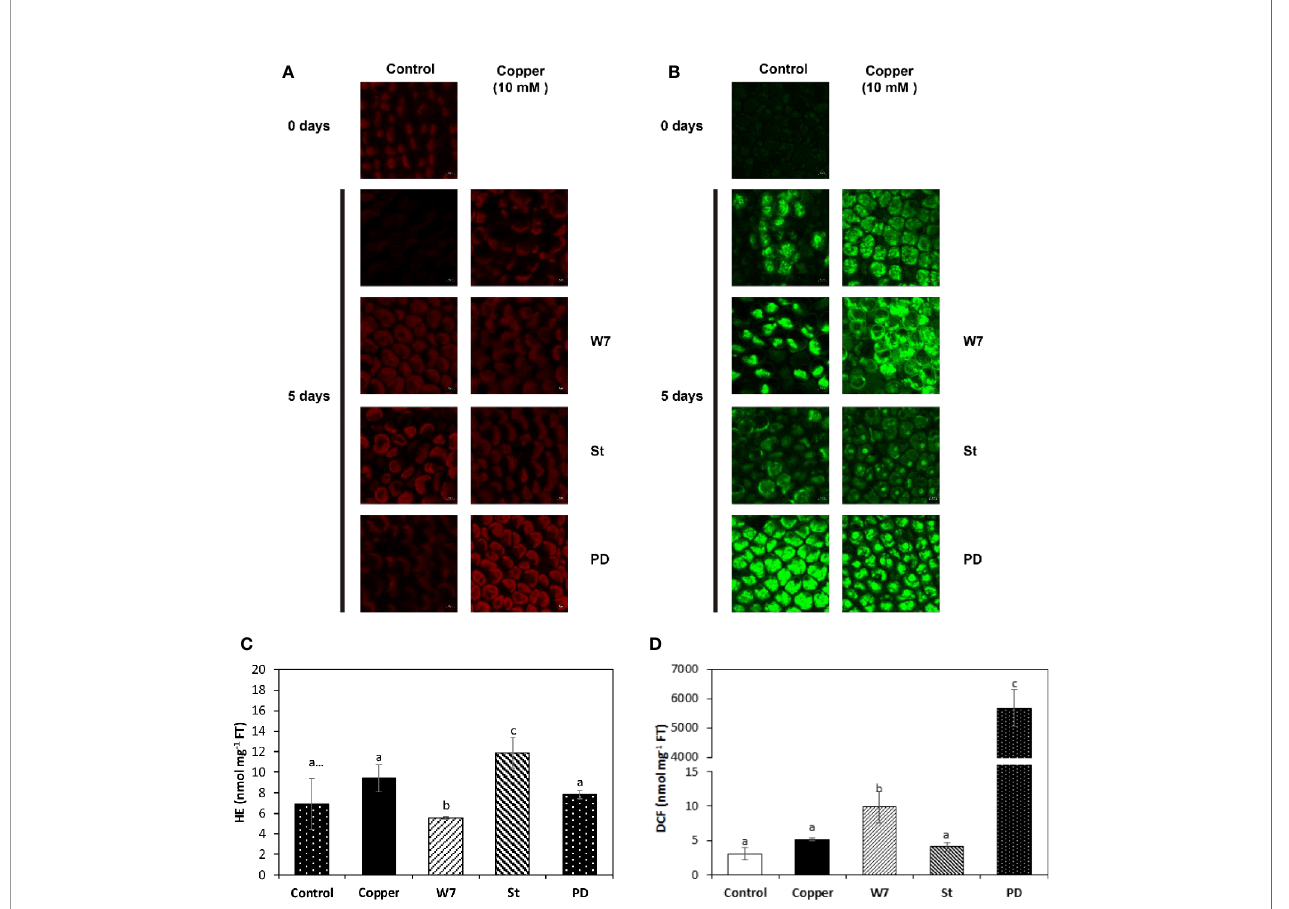
FIGURE 6 | Visualization of superoxide anions (SA, A ) and hydrogen peroxide (HP, B ) by confocal microscopy in U. compressa cultivated in seawater without copper addition (control), with 10 µM copper (copper), with 100 µM of W-7, 10 µM staurosporine (St), 5 µM PD-98059 (PD) and copper for 5 days. Levels of SA (C) and HP (D) in the alga cultivated in seawater without copper addition for 5 days (white bars), with 10 µM of copper (black bar), with 100 µM W-7, 10 µM St, 5 µM PD and 10 µM of copper for 5 days (hashed bars). Level of superoxide anions and hydrogen peroxide are expressed in nanomoles per milligram of fresh tissue (FT). Bars indicate mean values of three independent experiments. Different letters indicate signi fi cant differences among mean values (±SD) ( P <